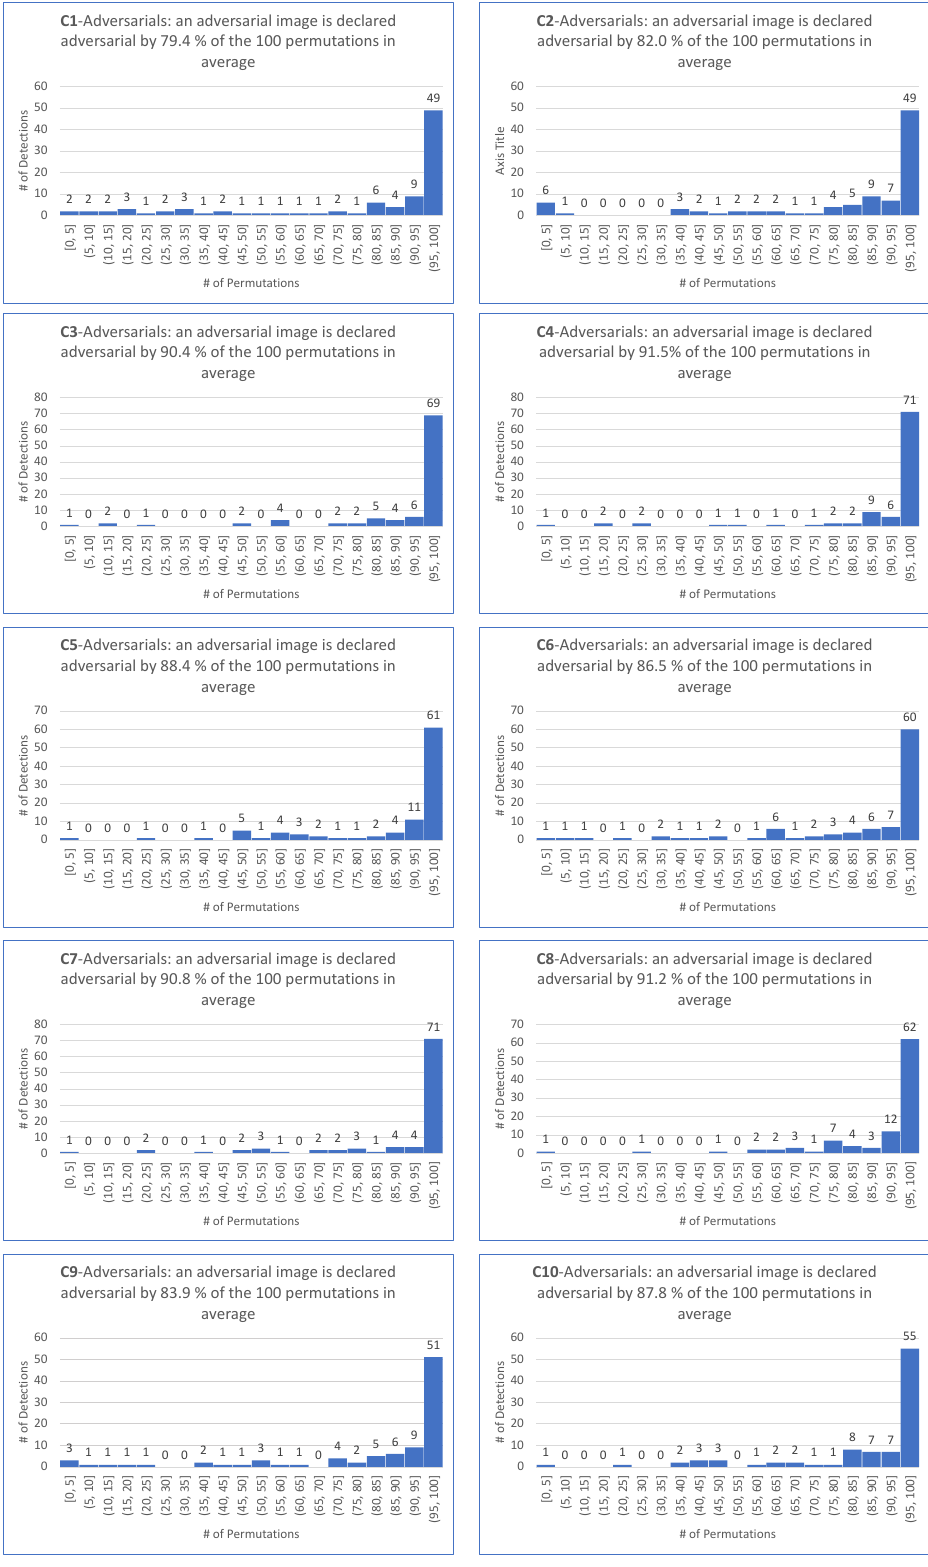
C1 -Adversarials: an adversarial image is declared adversarial by 79.4 % of the 100 permutations in average